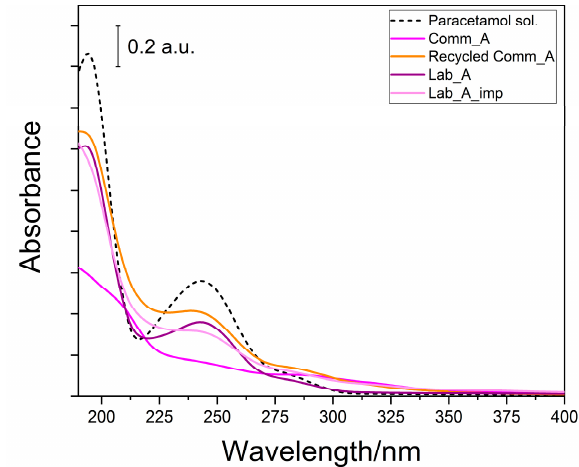
Figure 8. Comparison of the UV-vis spectra (190–400 nm range) of the supernatant solutions taken after 1 h reaction under 1 SUN with 1 g L − 1 of Comm_A, Recycled Comm_A, Lab_A, and Lab_A_imp powders in the presence of 0.01 mM paracetamol solution.